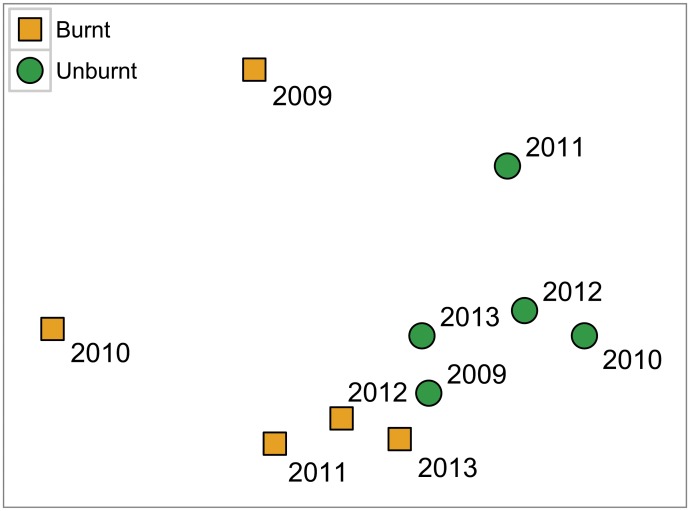
MDS plot of reptile community composition in each sampling year at burnt (square orange symbols) and unburnt sites (round green symbols).Stress = 0.05.